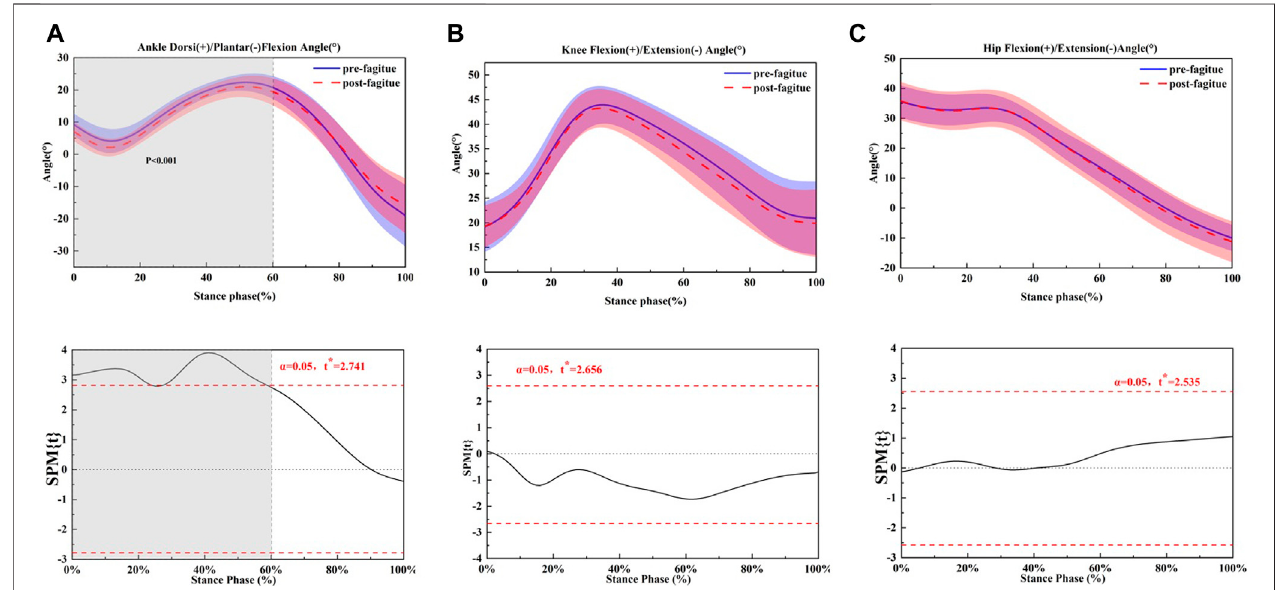
FIGURE 1 | Comparing the mean values of ankle, knee and hip joint angle from all participants between fatigue conditions (pre-fatigue; post-fatigue). * p ≤ 0.05.